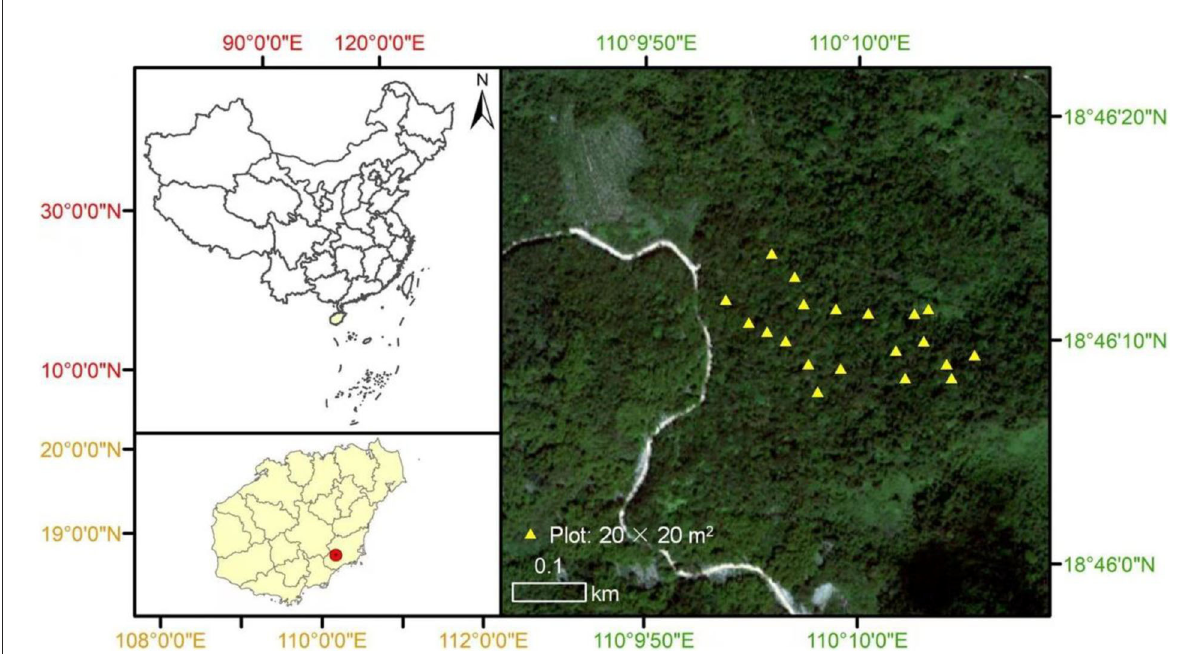
FIGURE1 The map of our study site and detailed spatial location of our 20 × 20 m 2 plots in the primary tropical lowland